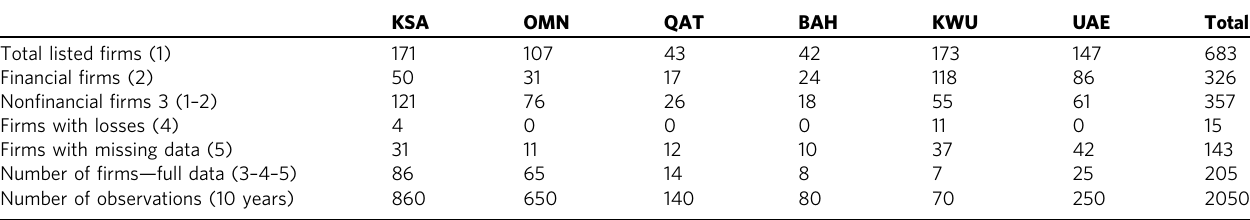
Table 1 Sample distribution by